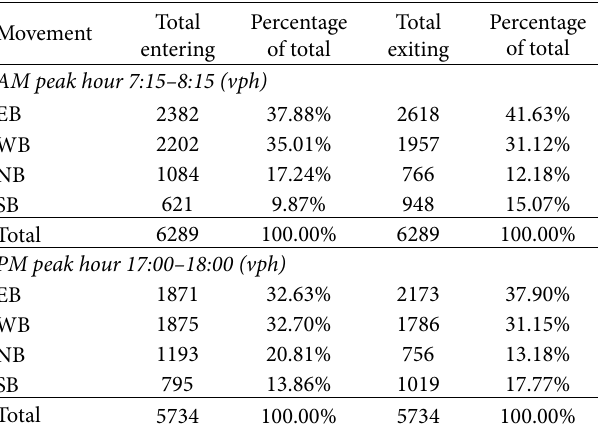
Table 3: Total number of entering and exiting vehicles in peak